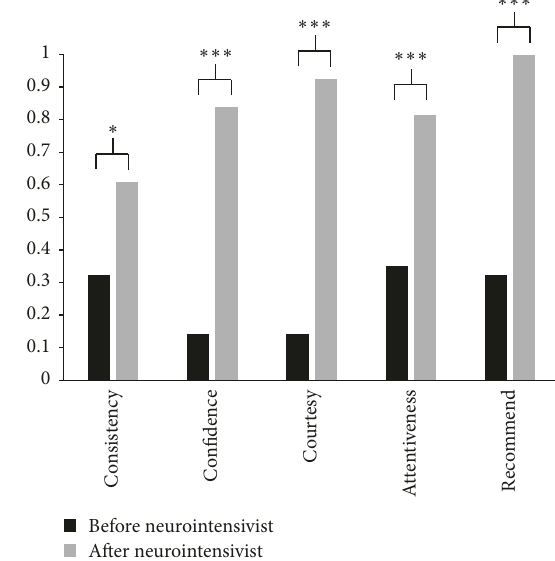
Figure 1: Patient Satisfaction Scores. Patient satisfaction scores from questionnaire data are illustrated. Before neurointensivists appointment is noted in black bars. After neurointensivist appoint- ment is noted in gray bars. Significant improvements in scores wereobservedwithallquestionsafterneurointensivistappointment. ∗ 𝑝 < 0.05 ; ∗∗∗ 𝑝 < 0.0001